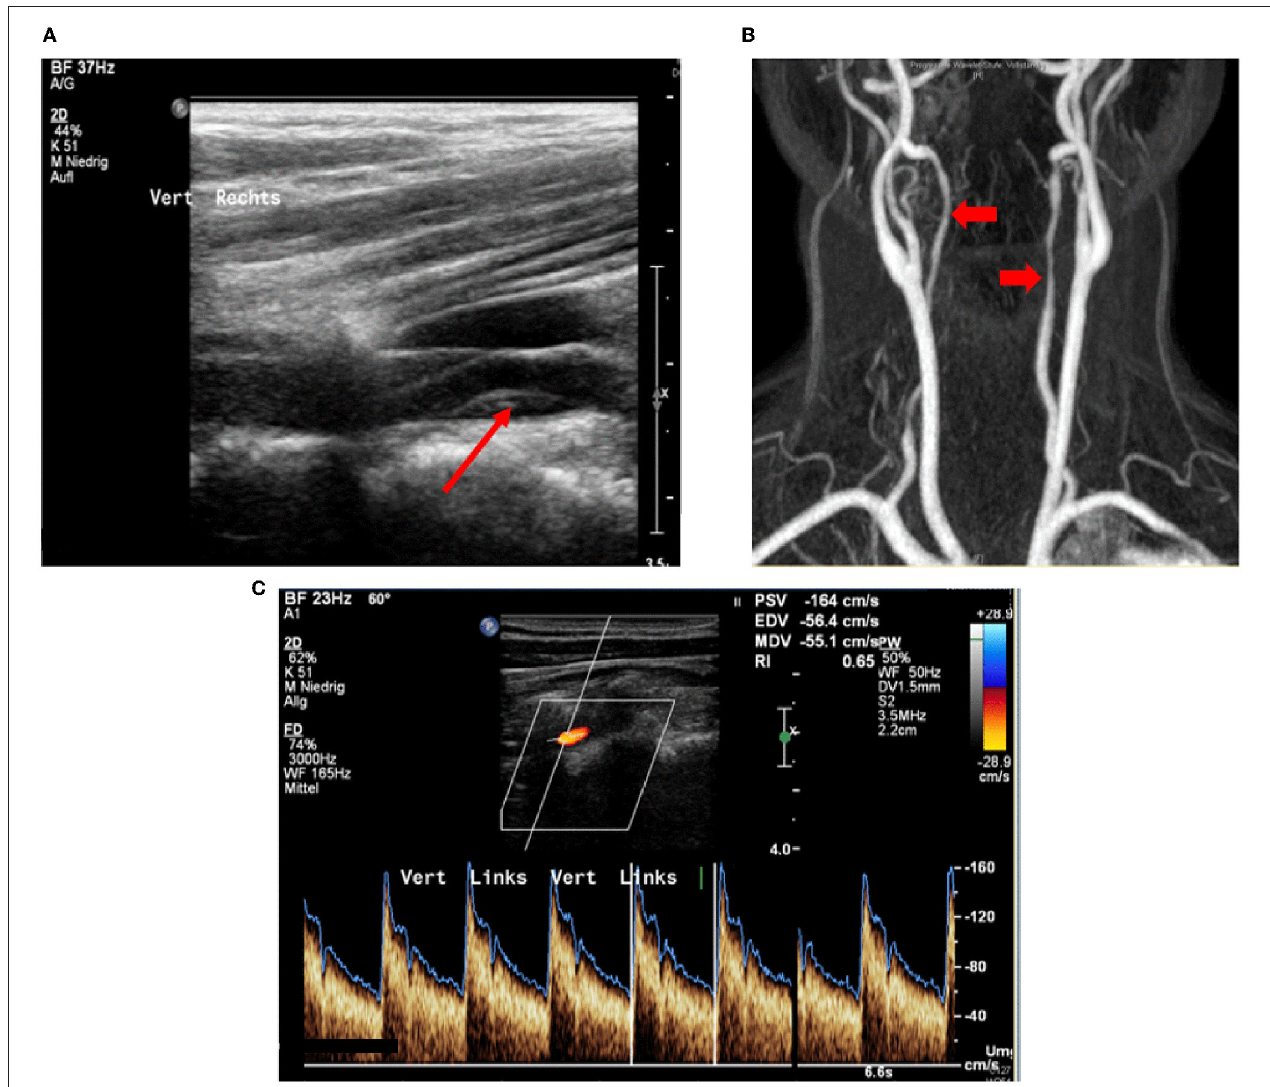
FIGURE 1 | (A) 48-year-old patient with neck pain; wall hematoma in B-mode (indicated by red arrow). (B) Corresponding magnetic resonance angiography with evidence of long-distance, irregular lumen narrowing in both vertebral arteries (indicated by red arrows). (C) Wall hematoma and lumen narrowing in B-mode, moderate stenosis (blood flow velocity: 160